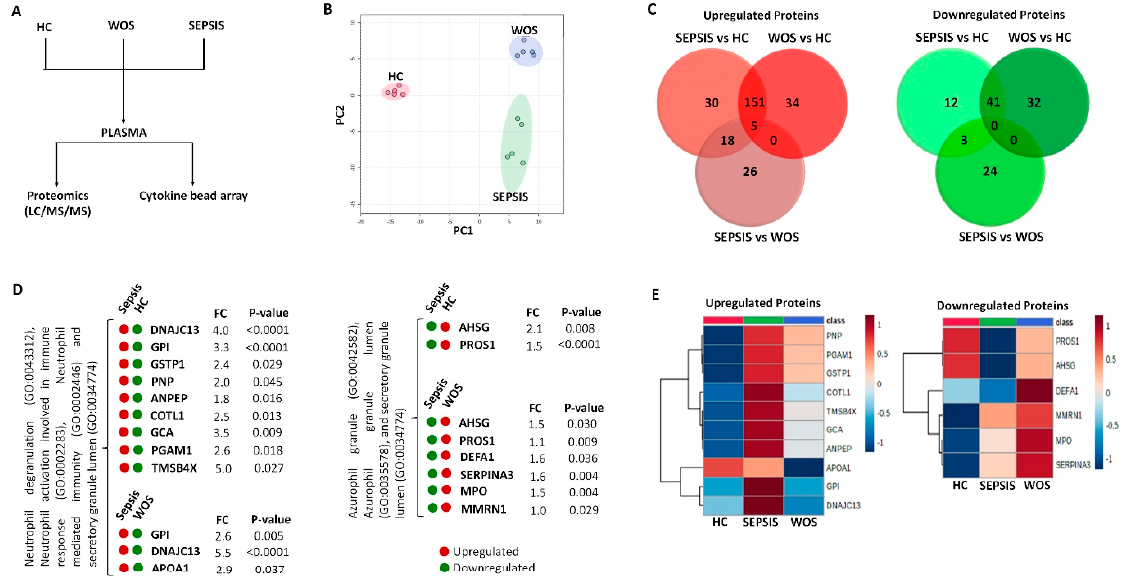
followed by probability adjustment by the Mann–Whitney.